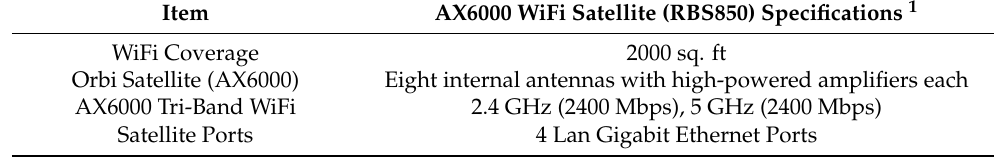
Table 2. WIFI 6 (802.11ax)